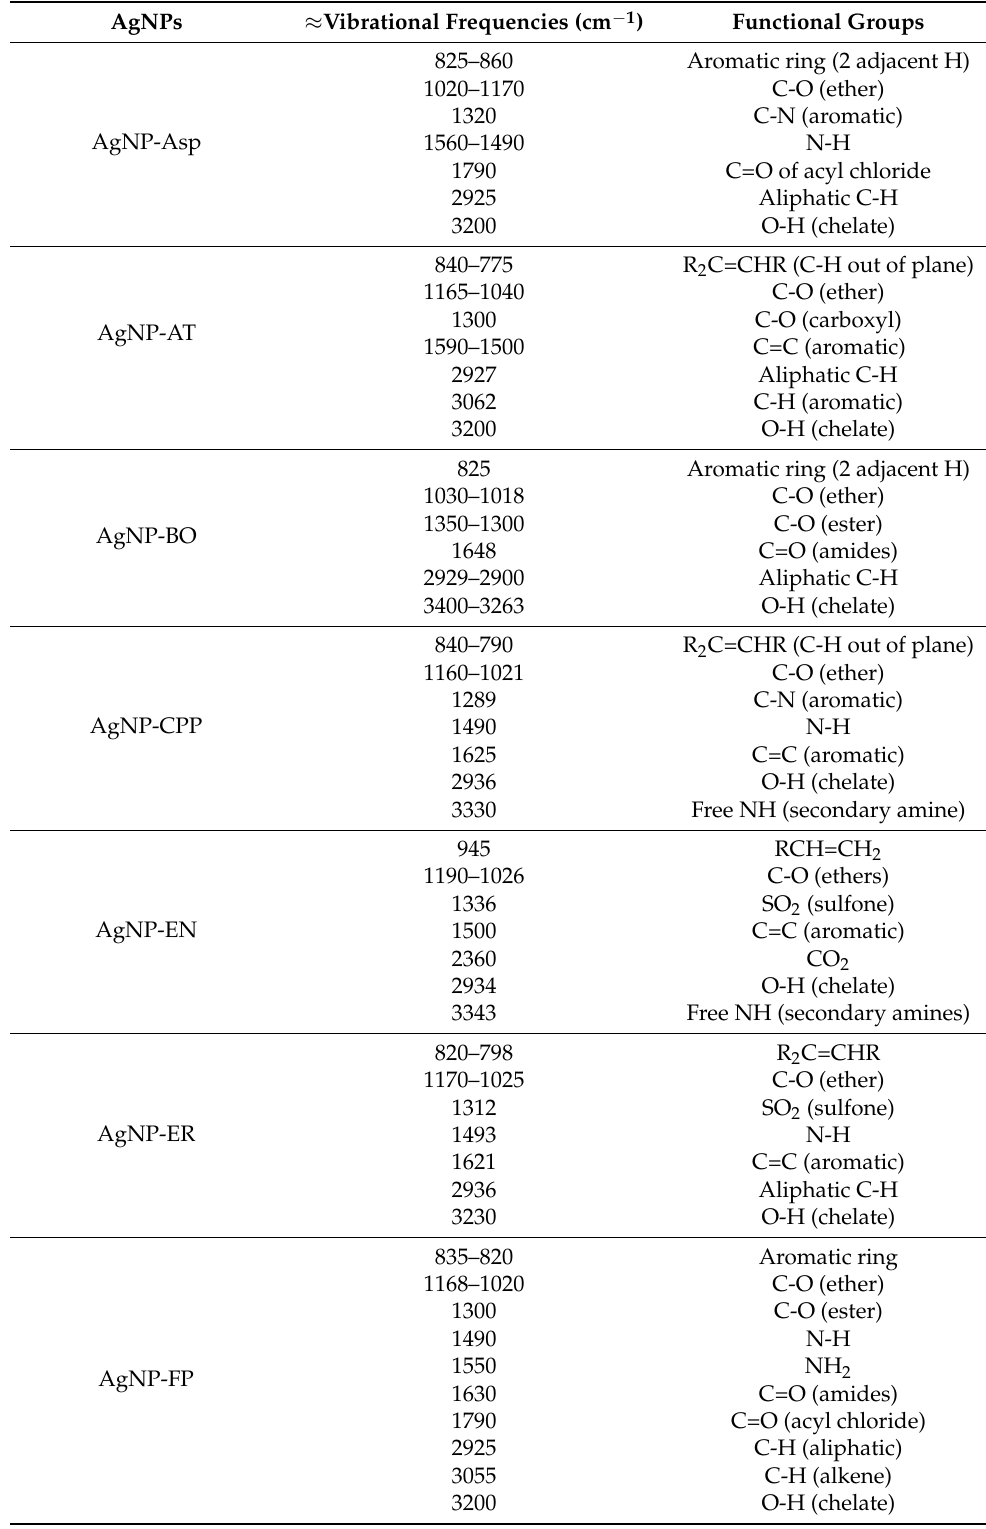
Table 2. Profile of vibrational frequencies (cm − 1 ) and functional groups present in the AgNP-Asp, AgNP-AT, AgNP-BO, AgNP-CPP, AgNP-EN, AgNP-ER, and AgNP-FP. Data obtained using Fourier- transform infrared (FTIR)